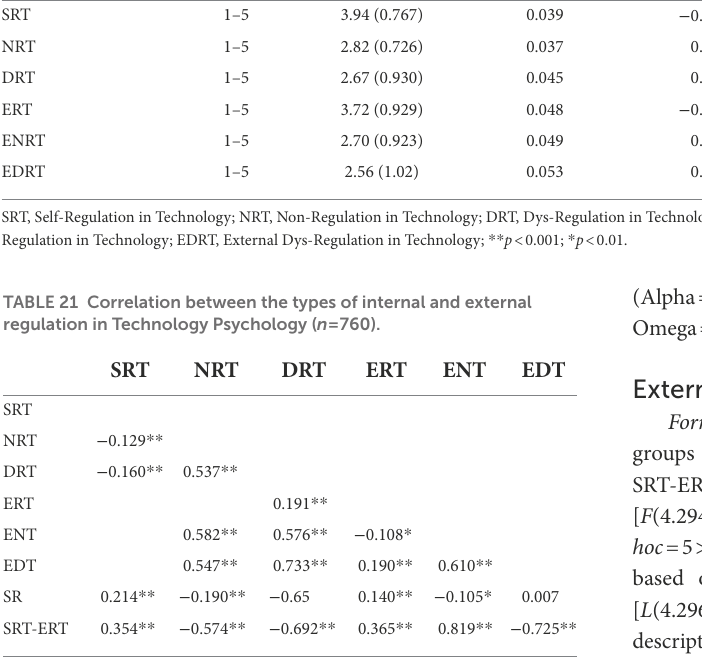
descriptive statistics.